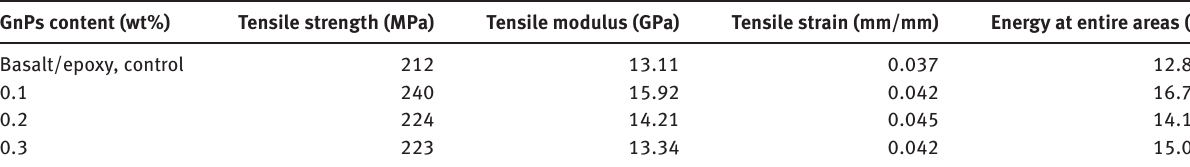
Table 1: The tensile test results of the produced test samples [30]. GnPs content (wt%)